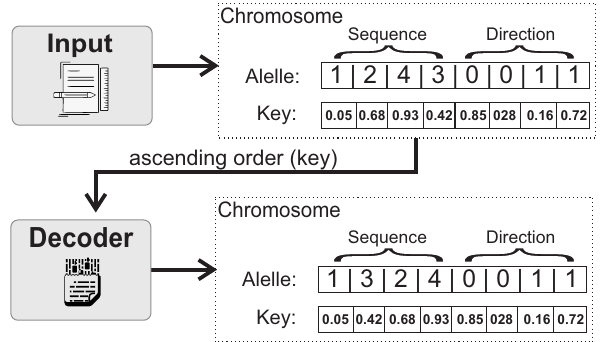
Figure 9. Decoder process to BRKGA